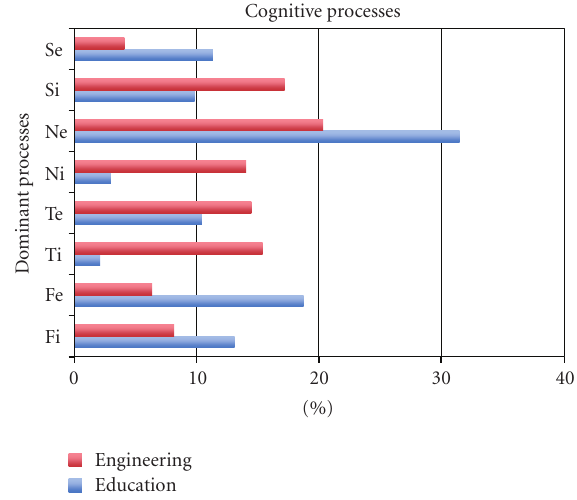
Figure 2: Frequencies of the dominant cognitive processes pre- ferred by 221 Engineering students and 336 Education